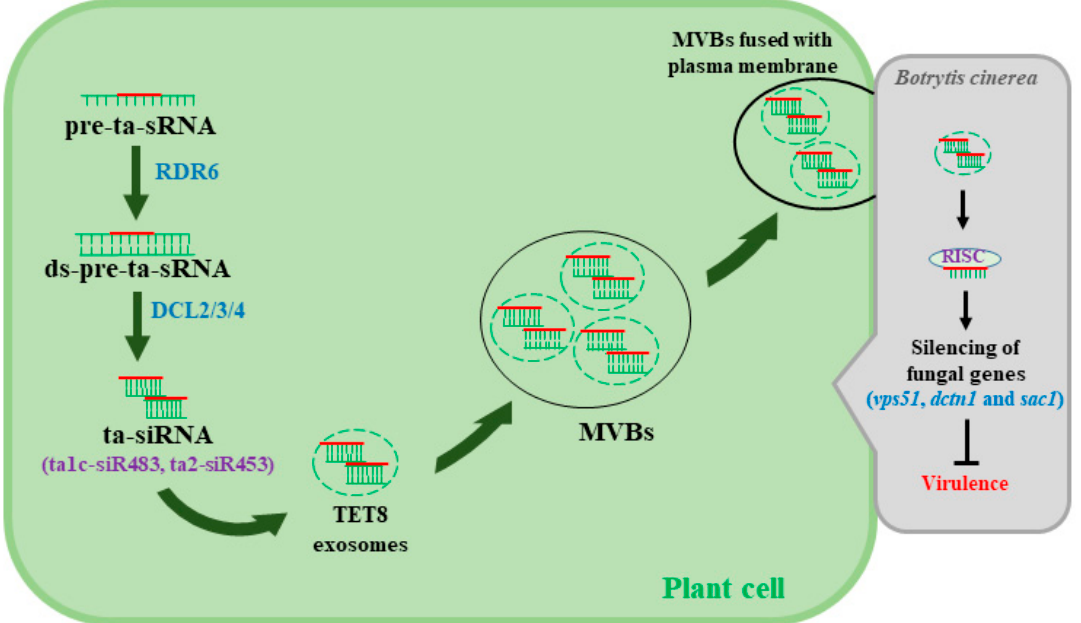
Figure 2. Plant delivers extracellular vesicles (EVs) containing siRNA to fungal cells to counteract Botrytis cinerea . Trans-acting siRNA (ta-siRNA) is processed by RNA-dependent RNA polymerase 6 (RDR6) and DCL2 / 3 / 4, and the processed ta-siRNA translocate through an unknown mechanism to tetraspanin 8 (TET8)-associated exosomes that are then assembled to form multivesicular bodies (MVBs). MVBs are fused with the plant plasma membrane to facilitate the transfer of siRNA to the invading fungal cells. The mechanisms behind the selection process of siRNA that translocate to the EVs and the release of siRNA into fungal cells to silence target virulence genes remain largely unknown.